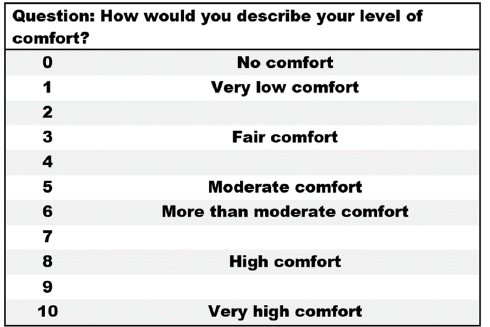
Figure 3. The eleven-point scale of perceived physical comfort